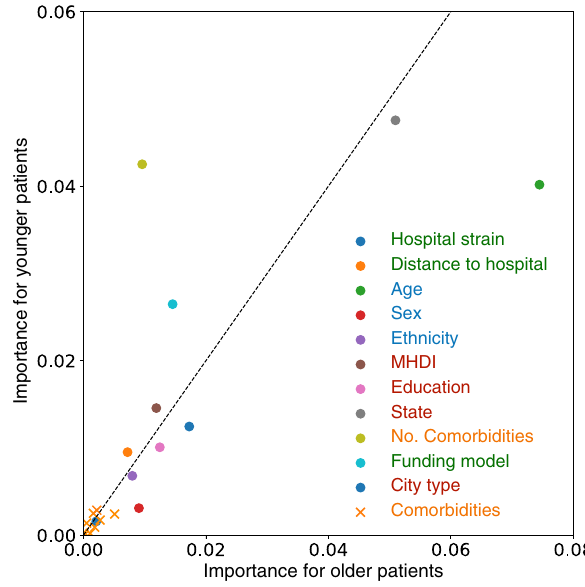
Figure 5. Feature importance for older and younger patients. Each point represents a feature in the SIVEP- Gripe dataset, and the axes show the relative importance for COVID-19 mortality prediction for older ( ≥ 60 years, x axis) and younger ( < 60 years, y axis) hospitalized patients. Variables deviating from the dotted identity line suggests a different relative importance for the groups. The coloring marks the categories listed in Fig. 1.